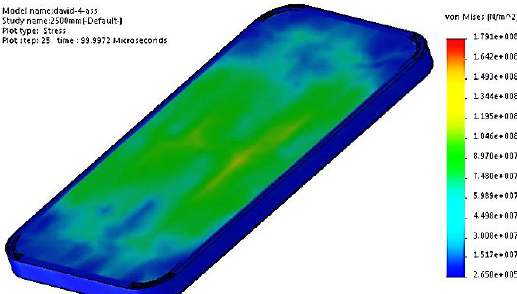
Fig. 6. Stress Distribution for a cellphone with Four Casing Laminate at 2500mm Drop